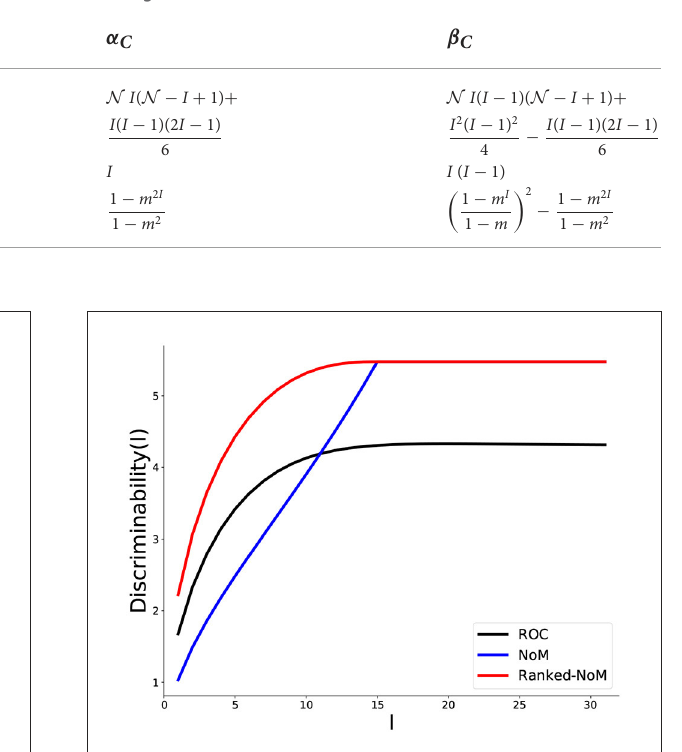
TABLE 3 Formulas for the expectation and variance coefficients of the different Integration schemes.